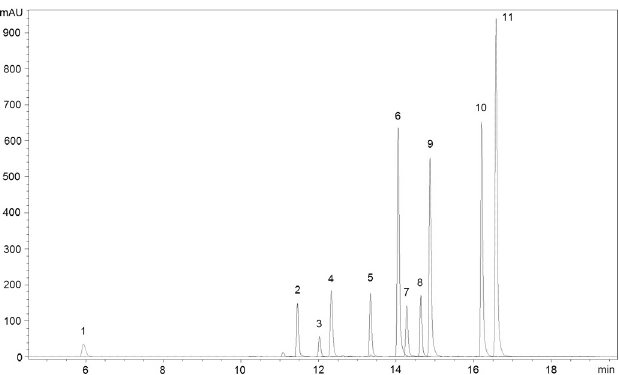
Fig. 1: HPLC separation of all standards detected at 280 nm (regression curves achieve a coefficient of variance of R 2 = 0:9995–0:9999; 1 gallocatechin, 2 procanidin B1, 3 epigallocatechin, 4 catechin, 5 procyanidin B2, 6 epigallocatechin gallate, 7 procyanidin C1, 8 epi- catechin, 9 gallocatechin gallate, 10 epicatechin gallate, 11 catechin